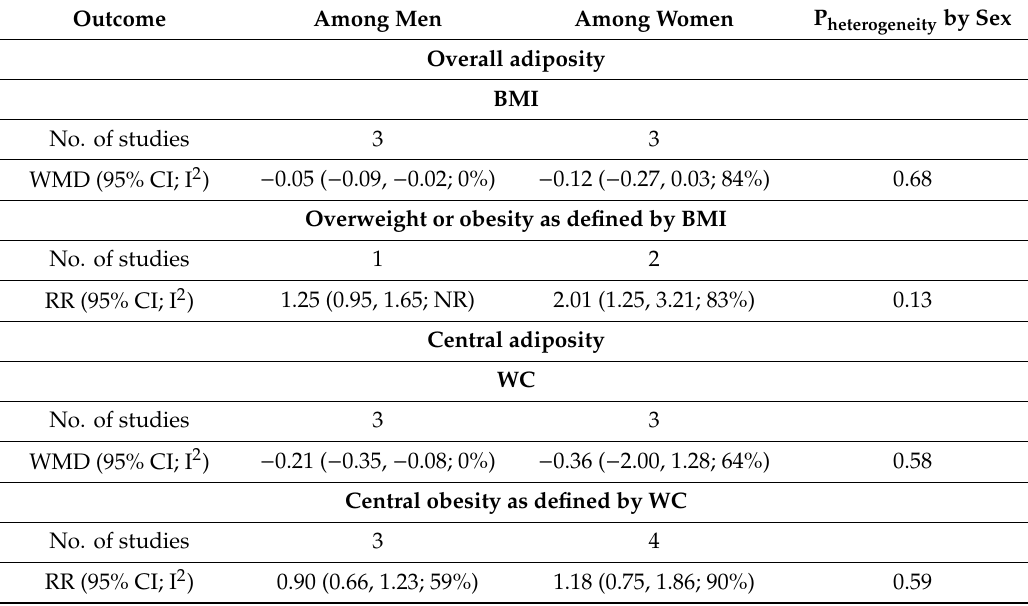
Table 1. Meta-analyses of co ff ee intake and overall and central adiposity by sex. Outcome Among Men Among Women P heterogeneity by Sex Overall